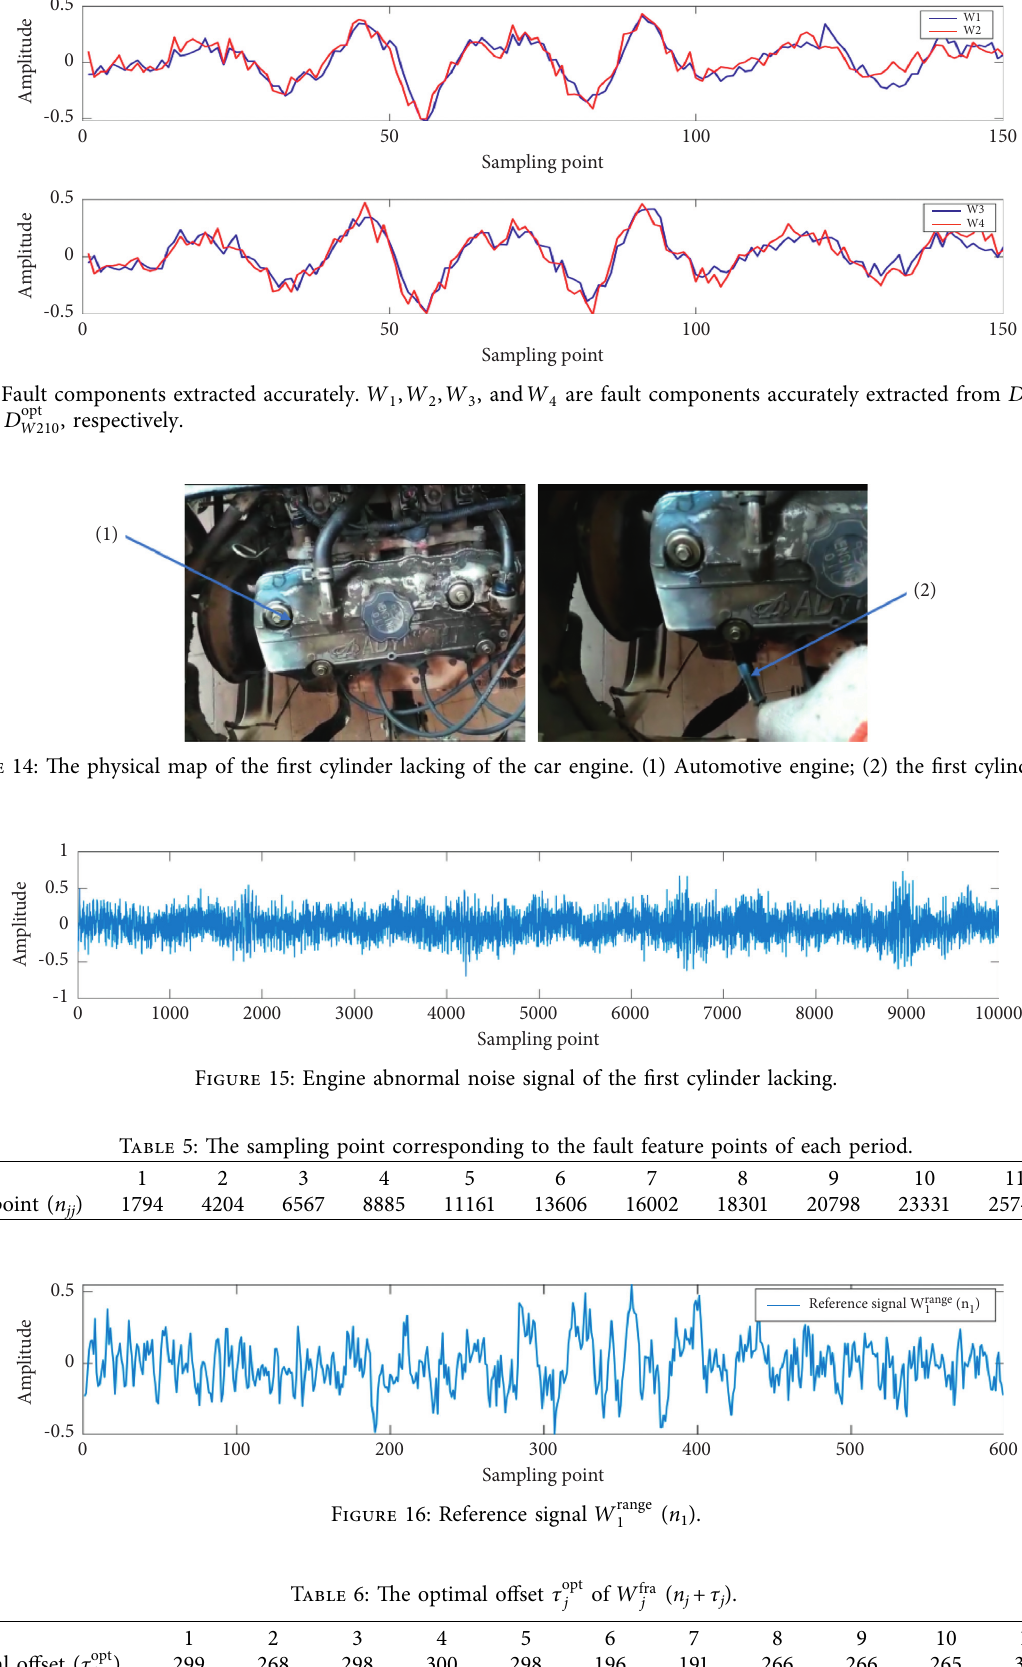
, D opt W , 114 214